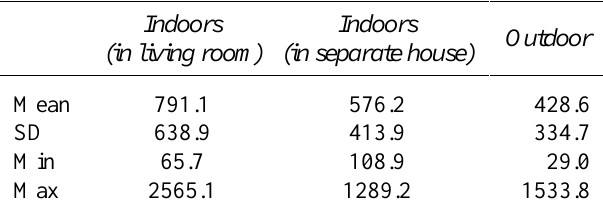
Table 3: PM concentration ( µg/m 3 ) measured during 10 cooking in different kitchen